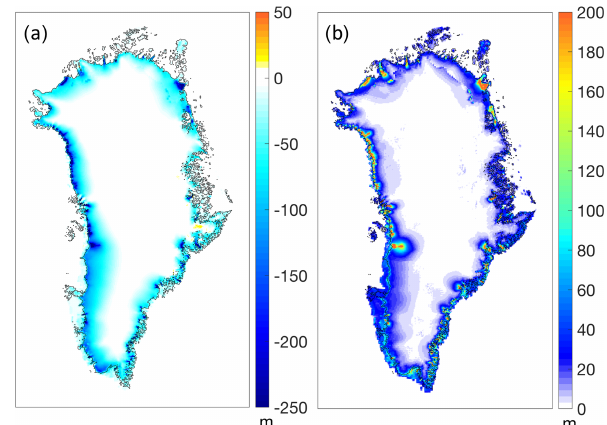
Figure 6. Ensemble mean (a) and standard deviation (b) of ice thickness change in MIROC5-RCP8.5 minus control over the 21st century. Thin black lines indicate the observed ice-covered area (Morlighem et al.,